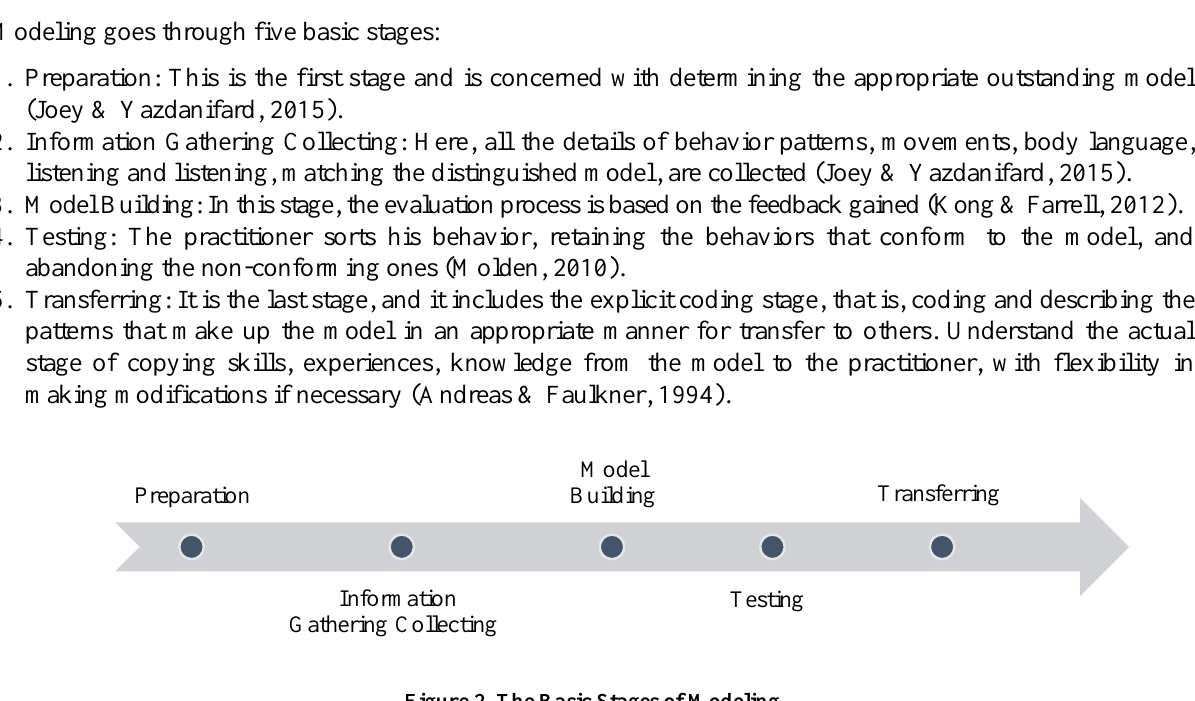
Figure 2. The Basic Stages of